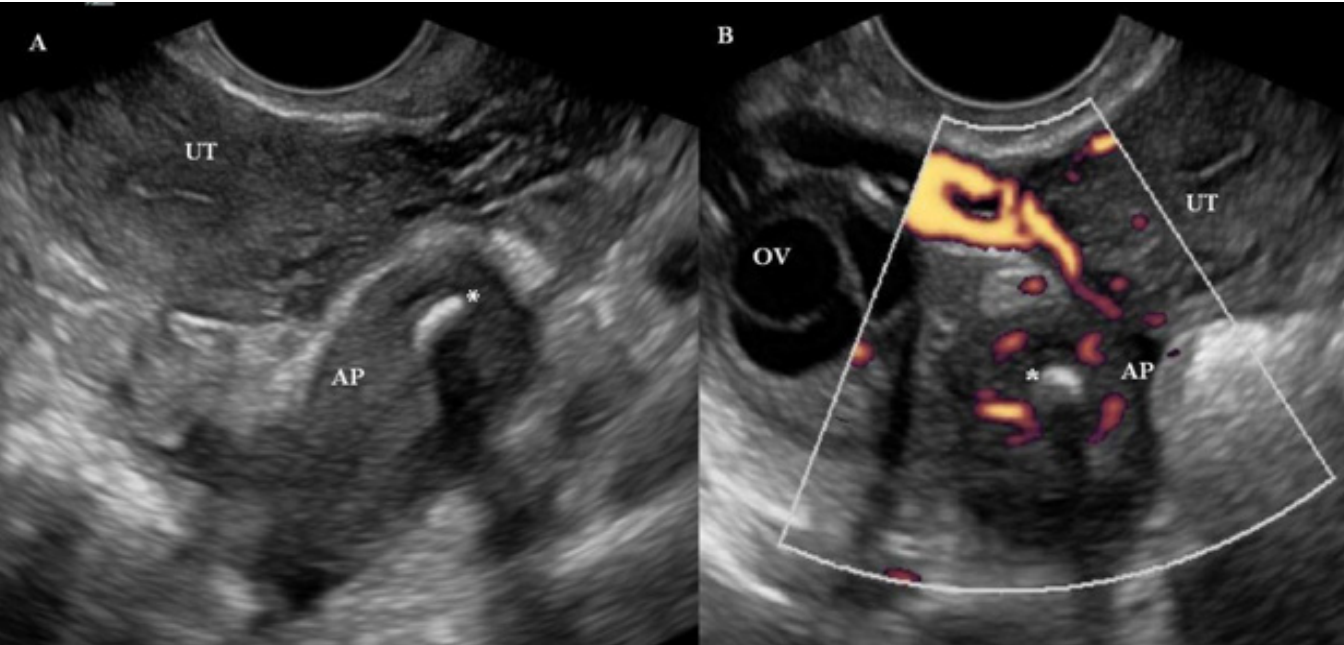
Figure 2. Transvaginal imaging of the right adnexa demonstrating appendicitis. (A) Enlarged appendix (AP) with appendicolith (*). The uterus (UT) is also seen. (B) Hyperemic appendix (AP) visualized in transverse, appendicolith (*), right ovary (OV), and uterus (UT)